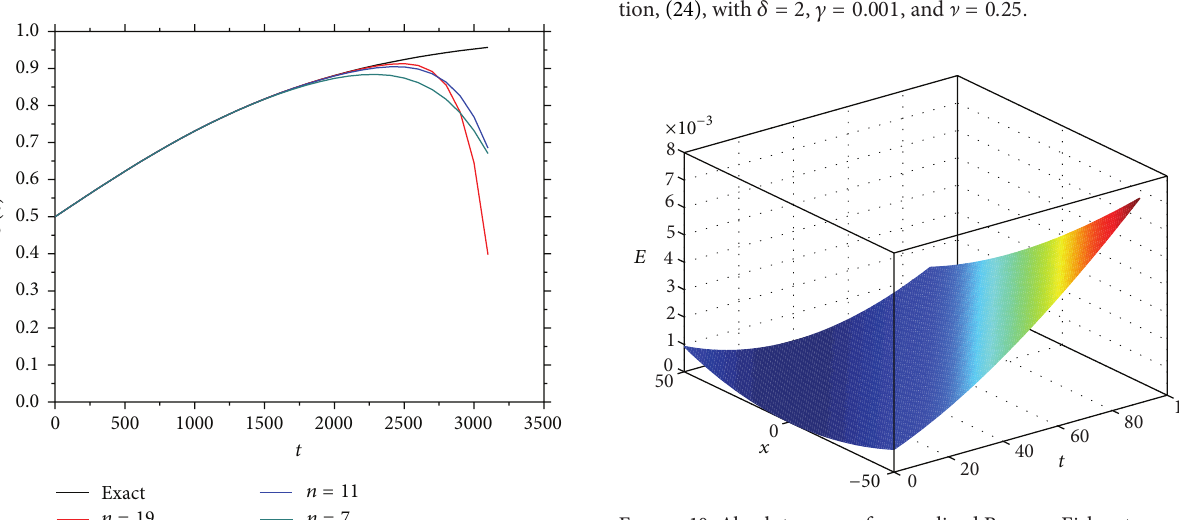
Figure 10: Absolute error of generalized Burgers-Fisher-type equa- tion, (24), with 𝛿 = 3 , 𝛾 = 0.001 , and ] = 1